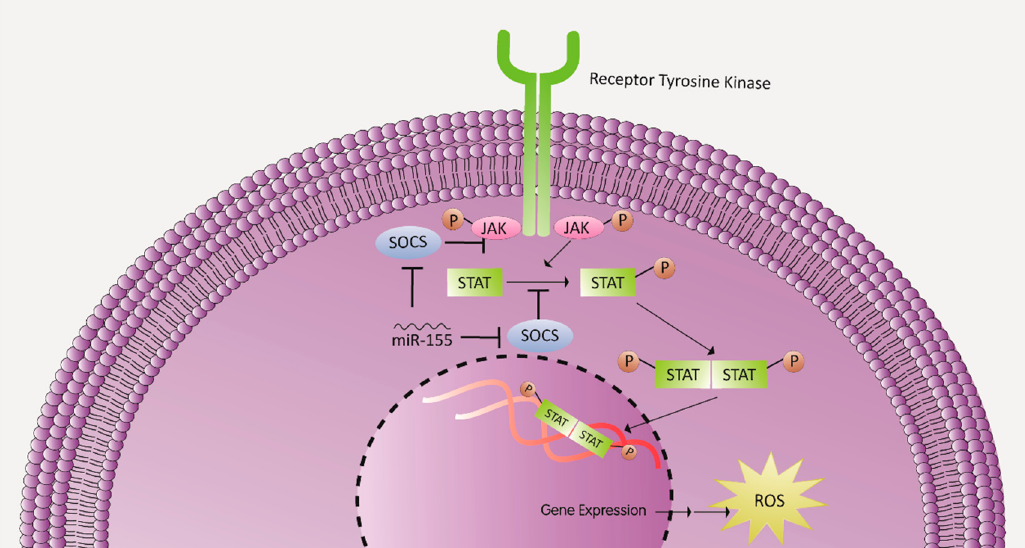
Figure 3. miR-155 role in increased ROS production: miR-155 increases ROS production by silencing SOCS, a negative regulator of the JAK/STAT signaling pathway, a pathway known to play a role in ROS generation. JAK: Janus kinase; STAT: signal transducer and activator of transcription. SOCS: suppressor of cytokine signaling.